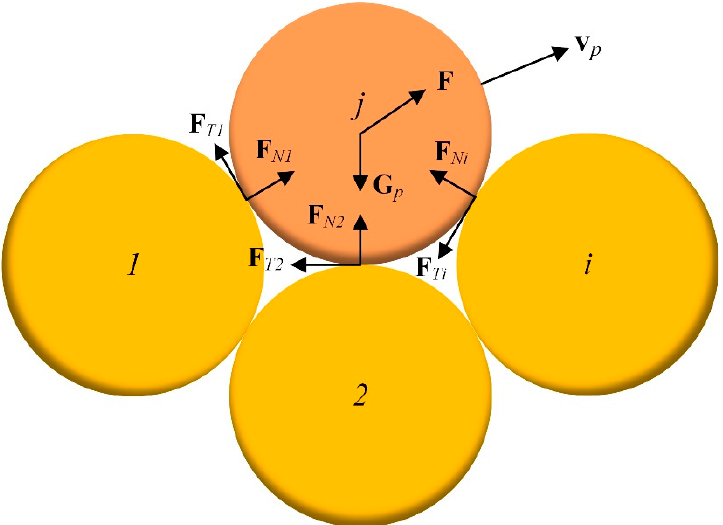
Figure 19. Diagram of forces on particles. 1, 2, i , j are the serial number of particles. F N1 , F N2 , F Ni and F T1 , F T2 , F Ti represent the normal contact force and the tangential contact force of particle 1, particle 2, particle i , respectively. F represents the fluid force, v p represents the velocity of particle j.